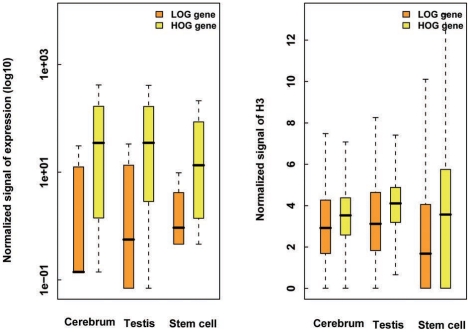
Box plots showing differential expression and NO levels between LOG and HOG genes.